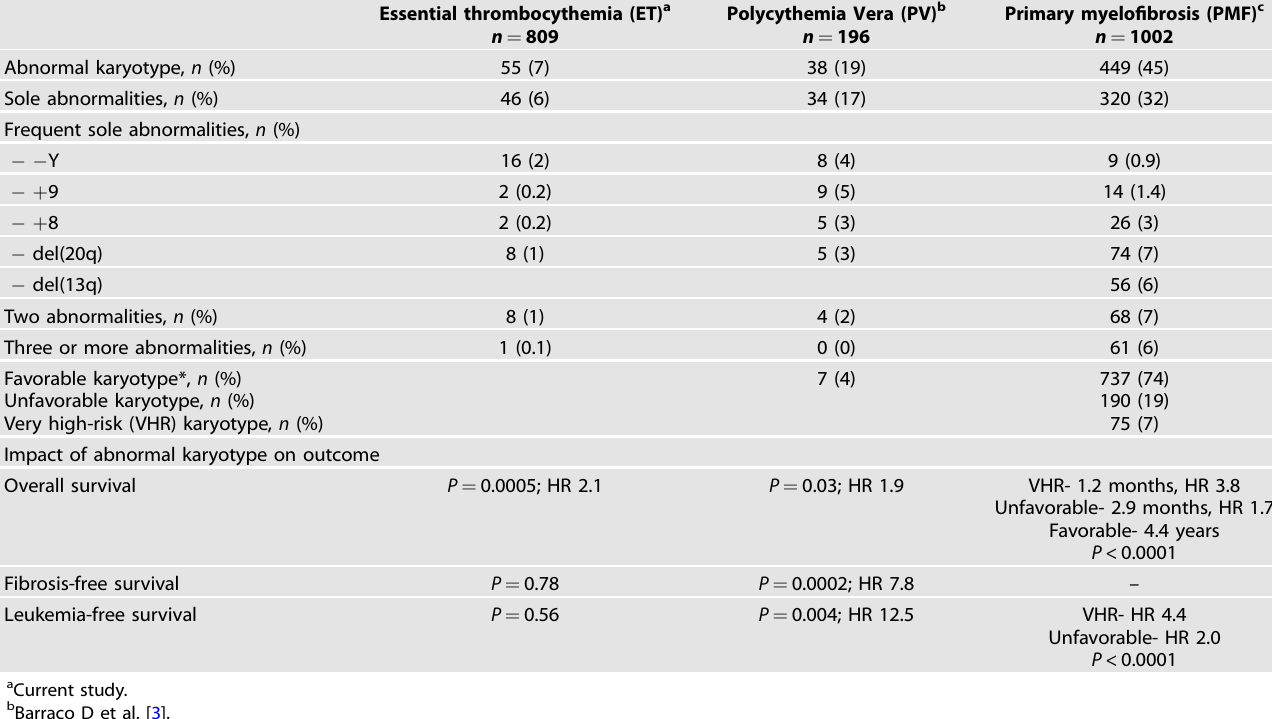
Table 5. Comparison of cytogenetic abnormalities in patients with essential thrombocythemia, polycythemia vera, and primary myelo fi